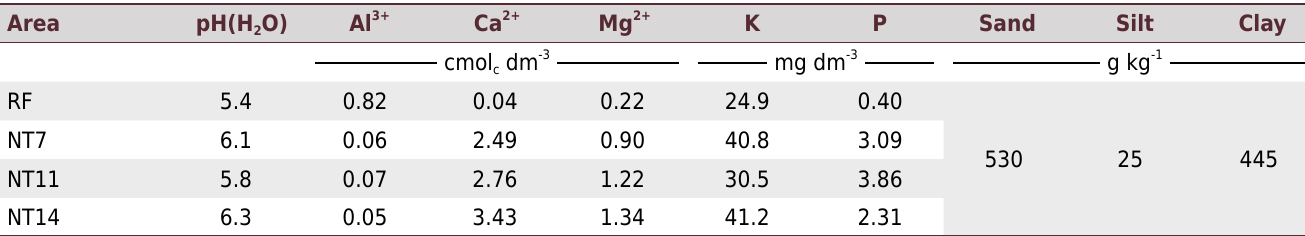
Table1. Physical-chemical properties of Plinthosol of the study areas Area pH(H 2 O)